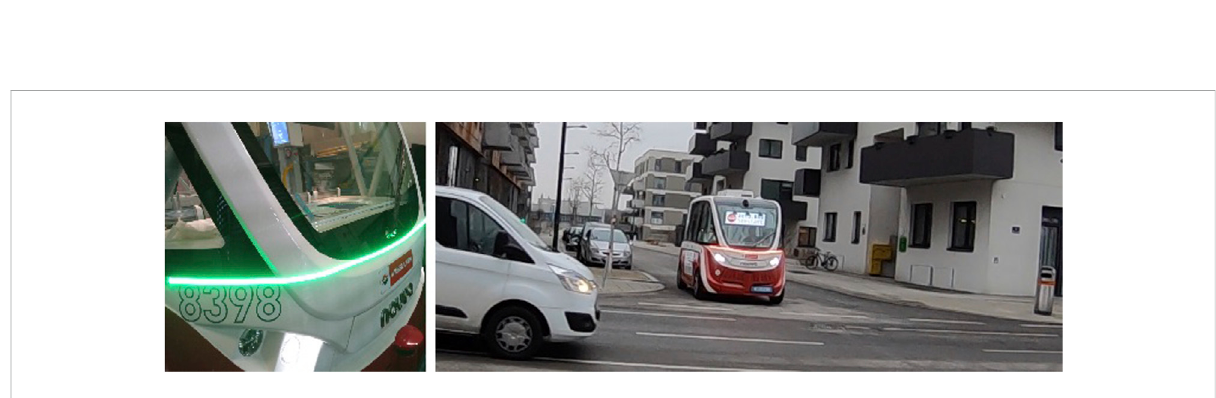
FIGURE 15 Front-mounted LED on the Navya Arma on close-up (left) and while the shuttle is circulating on the Vienna track